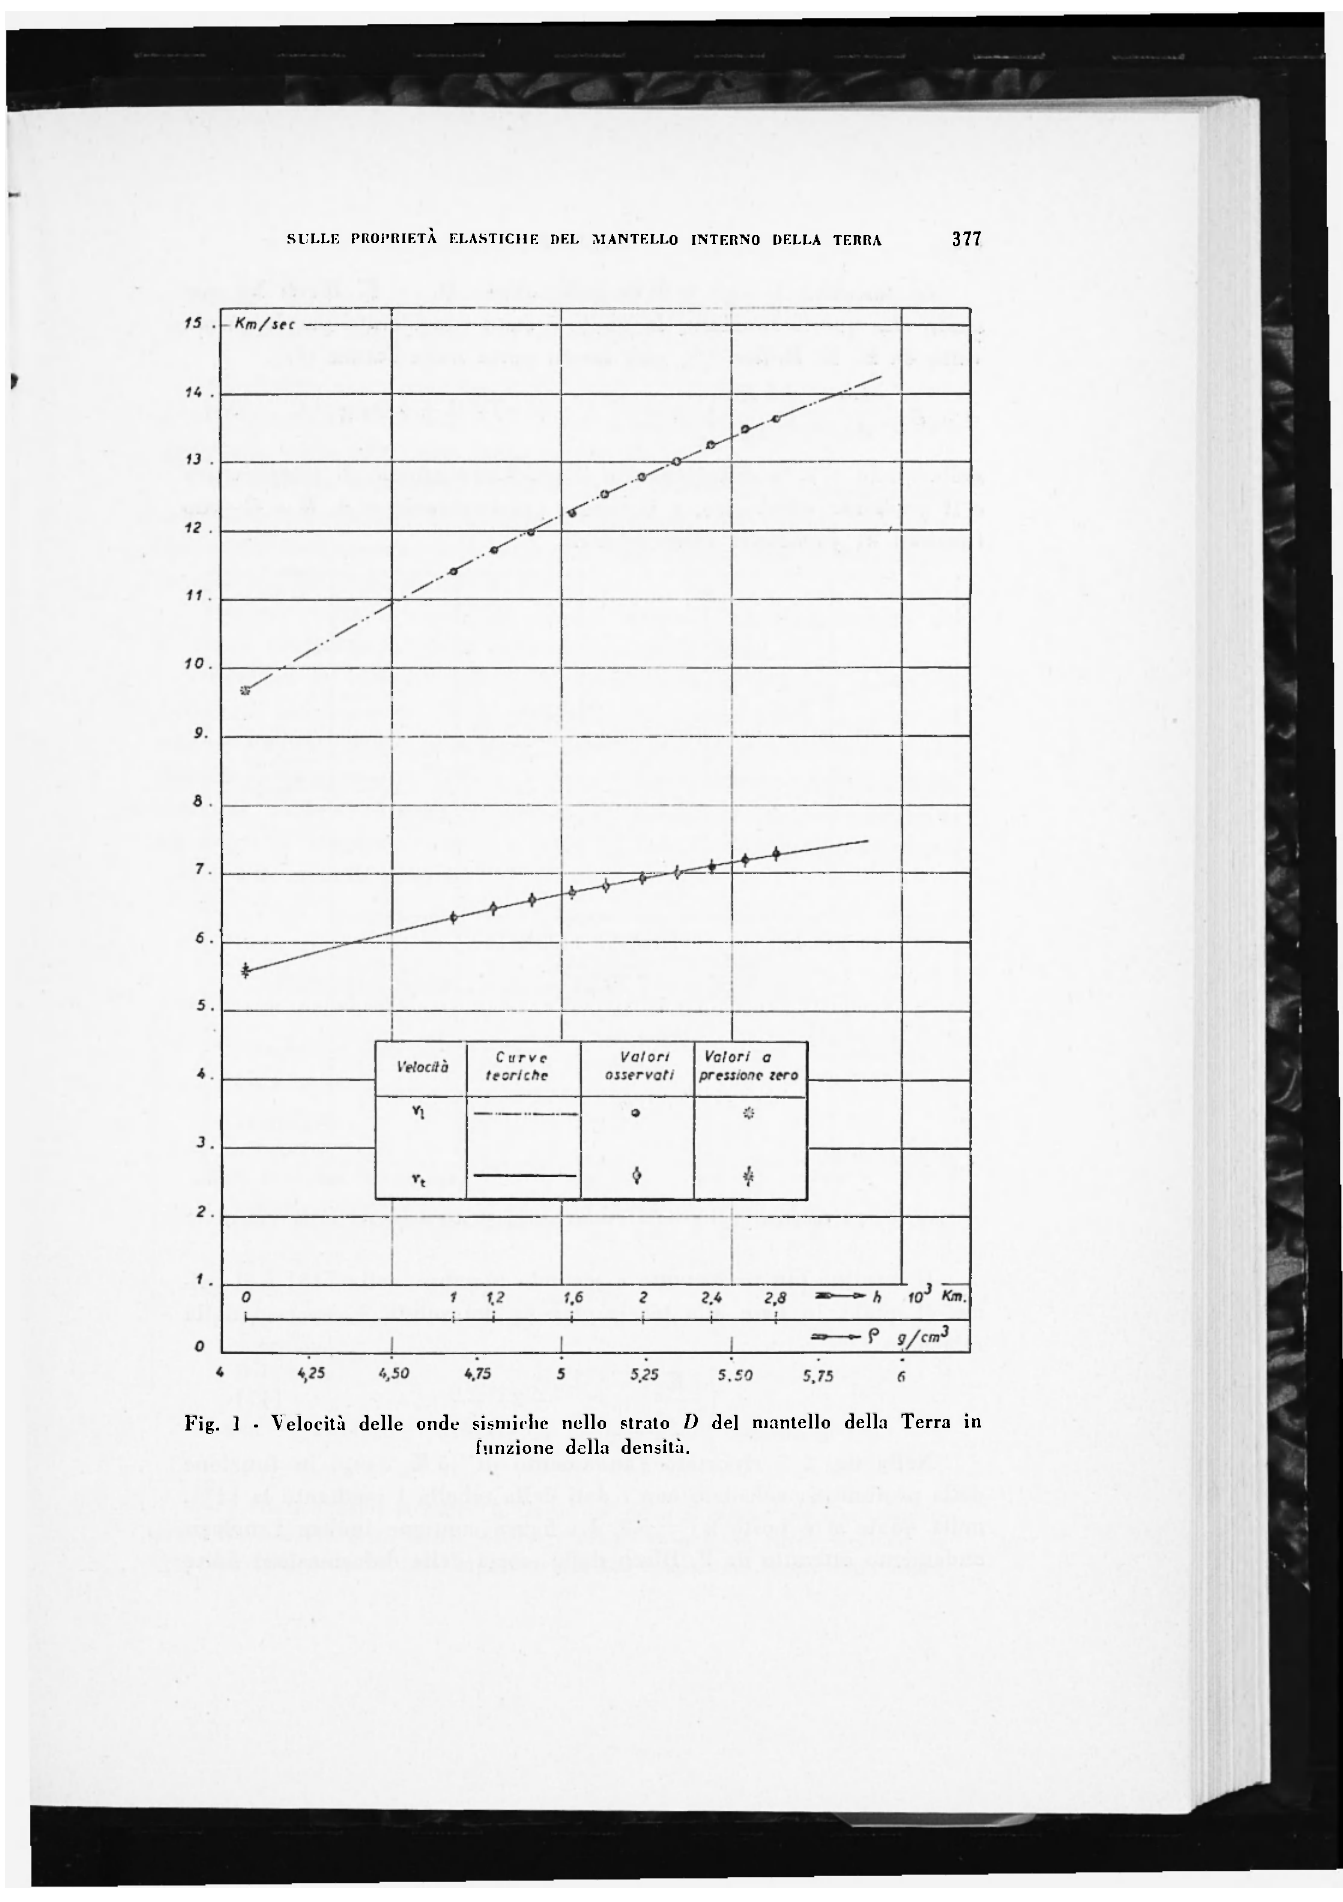
Fig. ] - Velocità delle onde sismiche nello strato D del mantello della Terra in funzione della